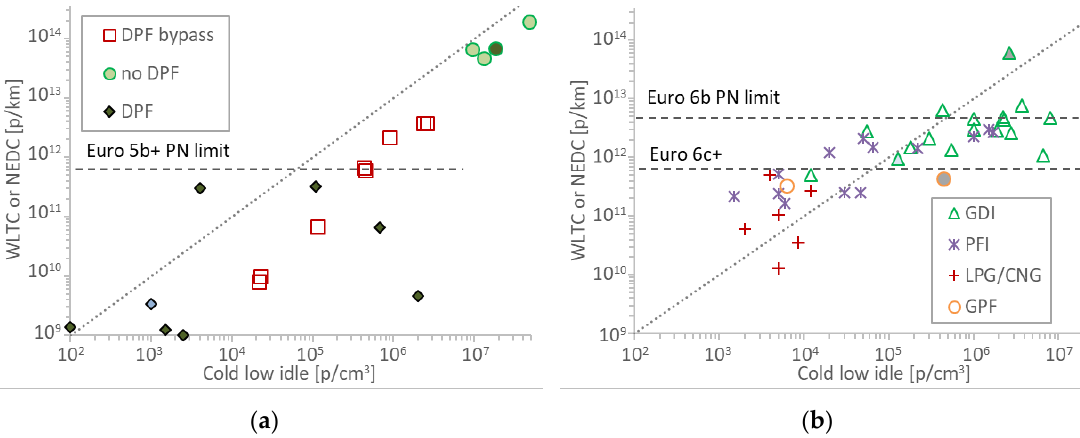
Figure 4. Scatter plots of cold idle concentrations with WLTC (Worldwide harmonized Light vehicles Test Cycle) or NEDC (New European Driving Cycle) type approval test cycles emissions: ( a ) compression ignition vehicles; ( b ) positive ignition vehicles. Each point is a vehicle. Hybrids have grey background. Vehicles with start and stop have light blue background. Horizontal lines give the respective Particle Number (PN) limits. CNG = Compressed Natural Gas; DPF = Diesel Particulate Filter; GDI = Gasoline Direct injection; GPF = Gasoline Particulate Filter; LPG = Liquefied Petroleum Gas; PFI = Port Fuel Injection; PTI = Periodical Technical Inspection.